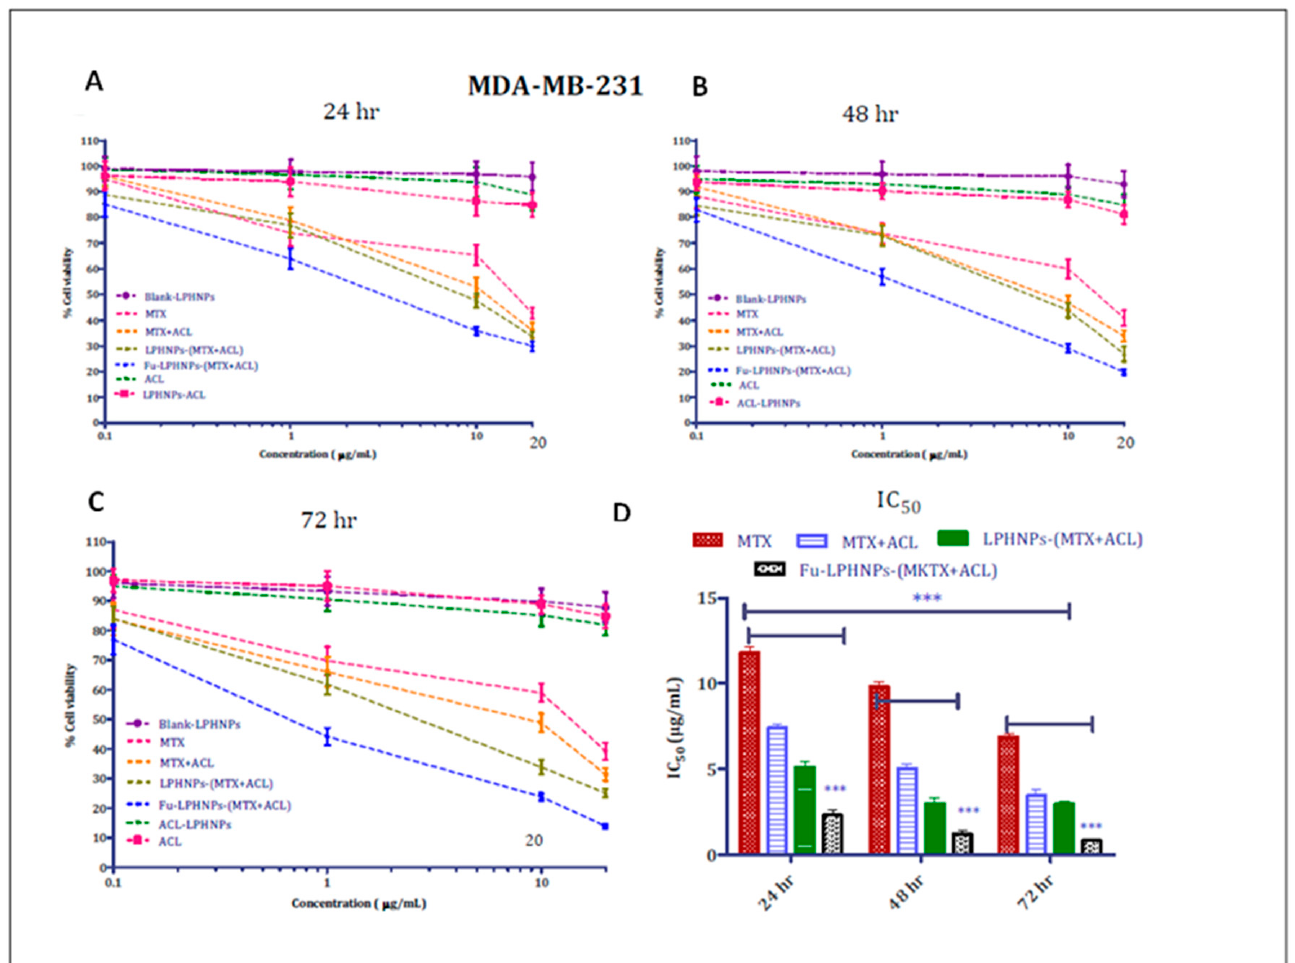
Figure 6. The in vitro anti-cancer activity of MTX- and ACL-based free and co-encapsulated LPHNPs after 24 ( A ), 48 ( B ), and 72 h ( C ) in MDA-MB-231 cell lines. The image ( D ) depicts the comparison of IC 50 of different samples obtained after 24, 48, and 72 h (*** p < 0.05). The statistics were run to determine significance in IC 50 by 2-way ANOVA, and data are presented as the mean of three independent experiments (SD, n = 6). Reprinted (adapted) with permission from [89]. Copyright (2017) American Chemical Society.